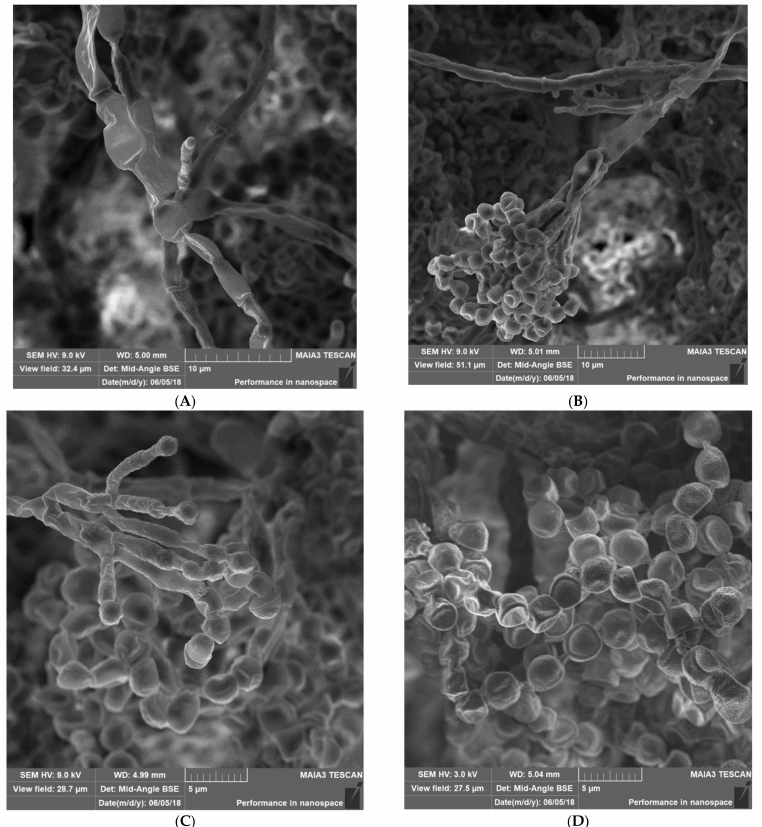
Figure 2. Morphology of Flavus . ( A – C )—stages of formation of spore-bearing structure, ( D )—chain of spores.